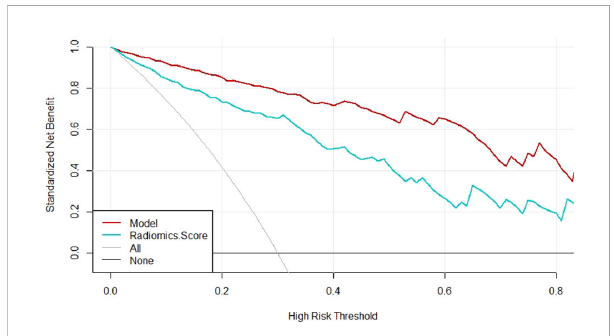
FIGURE 7 Decision curve analysis for the model and radiomics